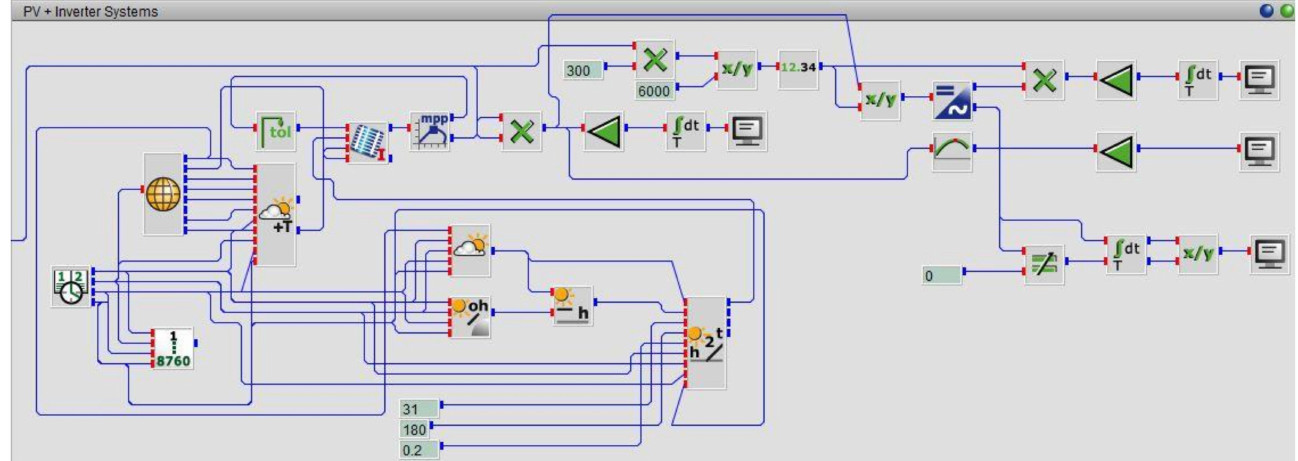
Figure 4. A screenshot from PV system modeled in INSEL, including weather block, PV panels. inverter and